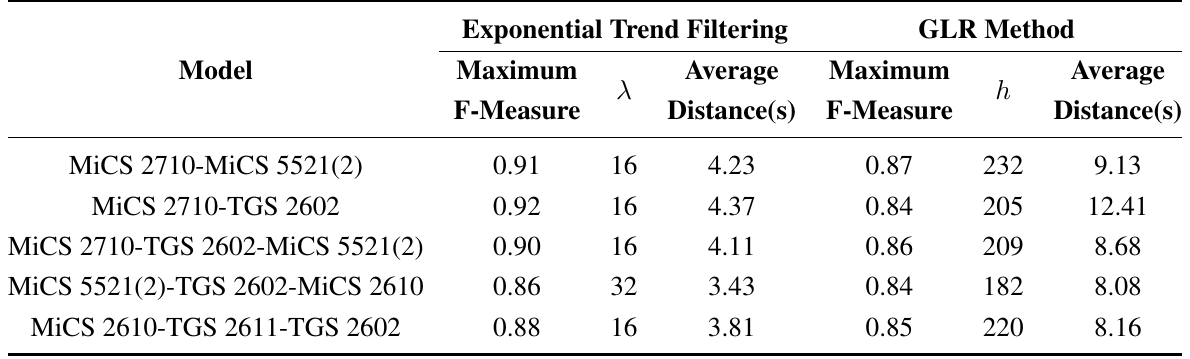
Table 6. Maximum F-measure calculated by Multivariate TREFEX using l Multivariate GLR for selected subset of the array. The corresponding hyper-parameters and detection intervals of maximum F-measure are also